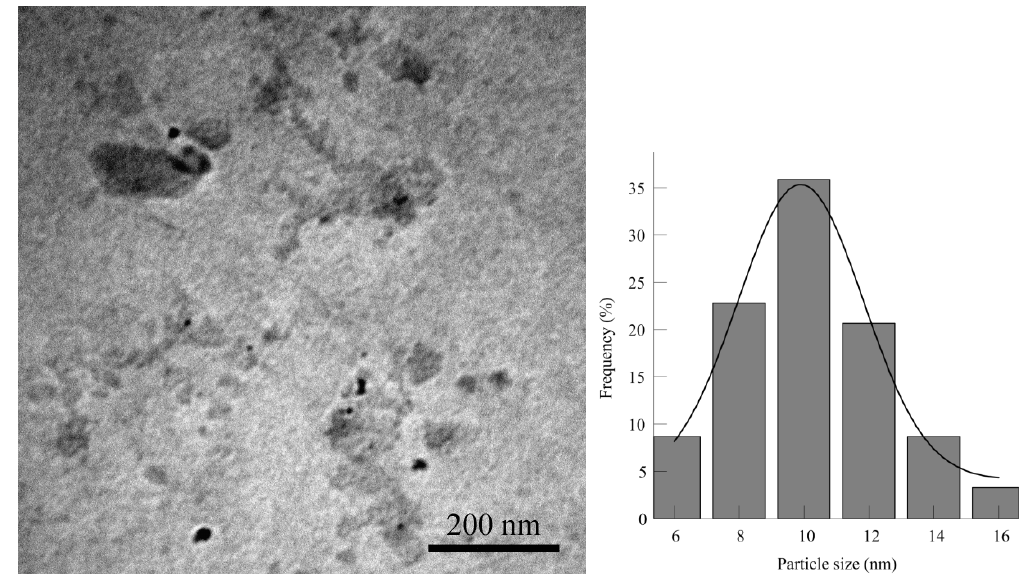
Figure 4. TEM image and particle size distribution histogram of CdS